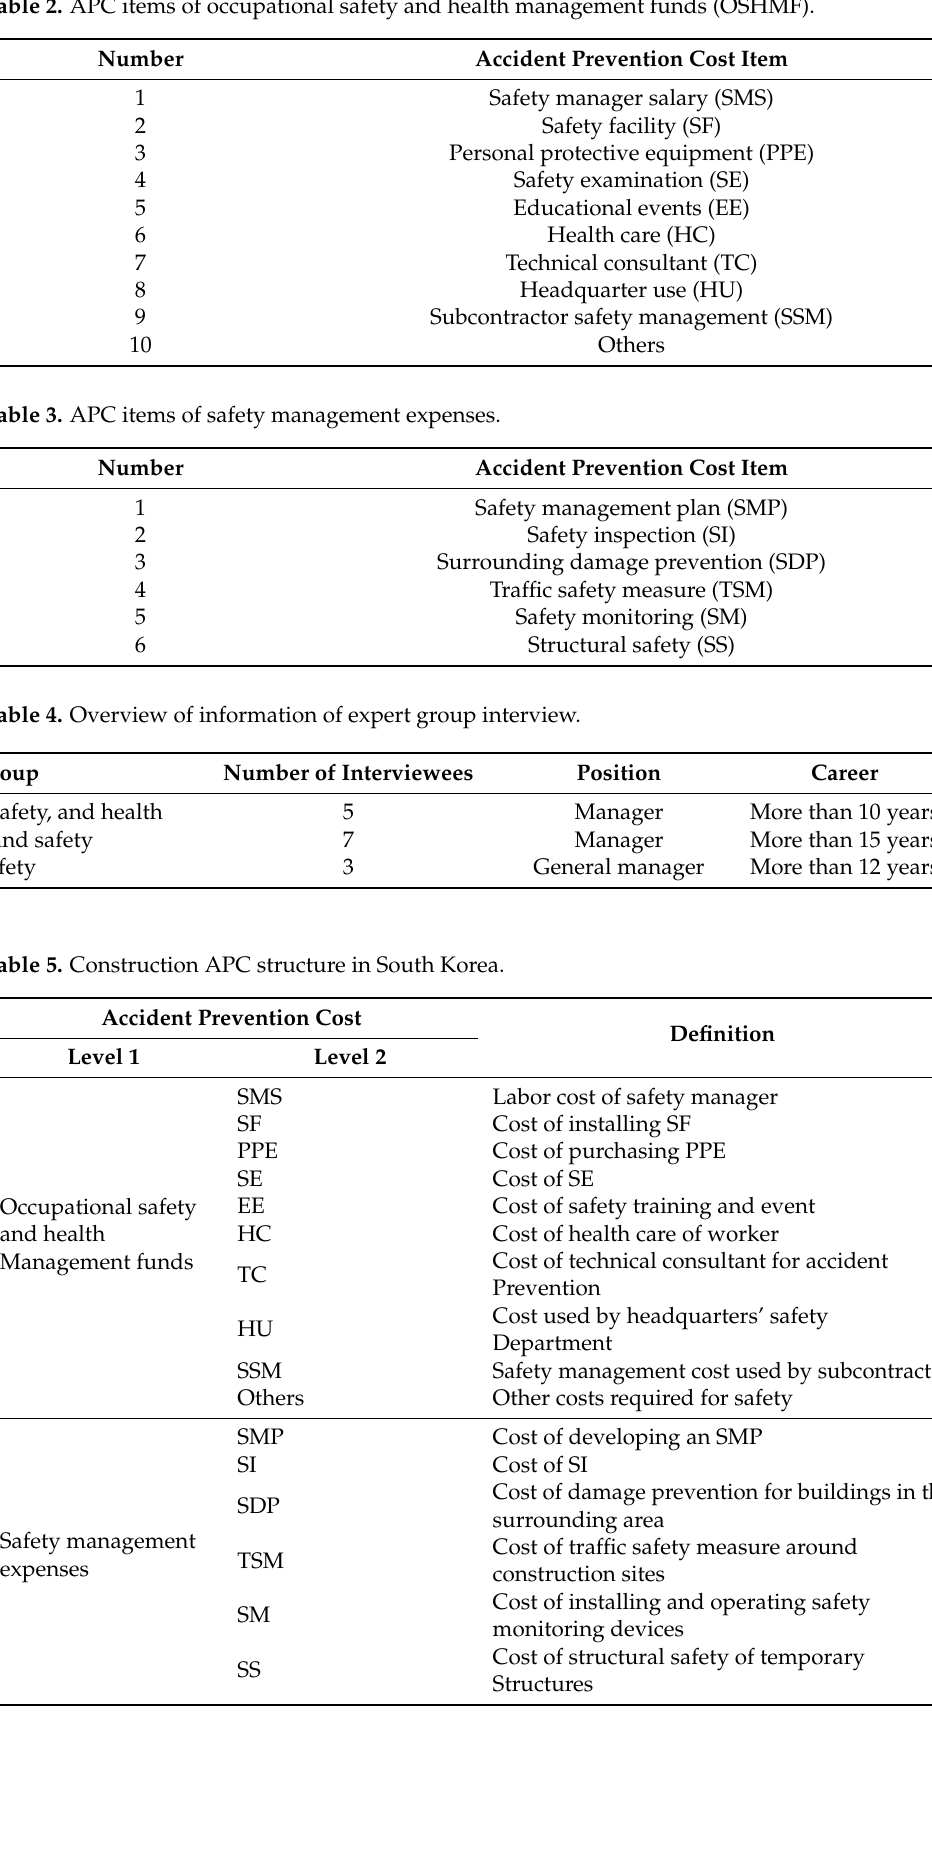
Table 2. APC items of occupational safety and health management funds (OSHMF).